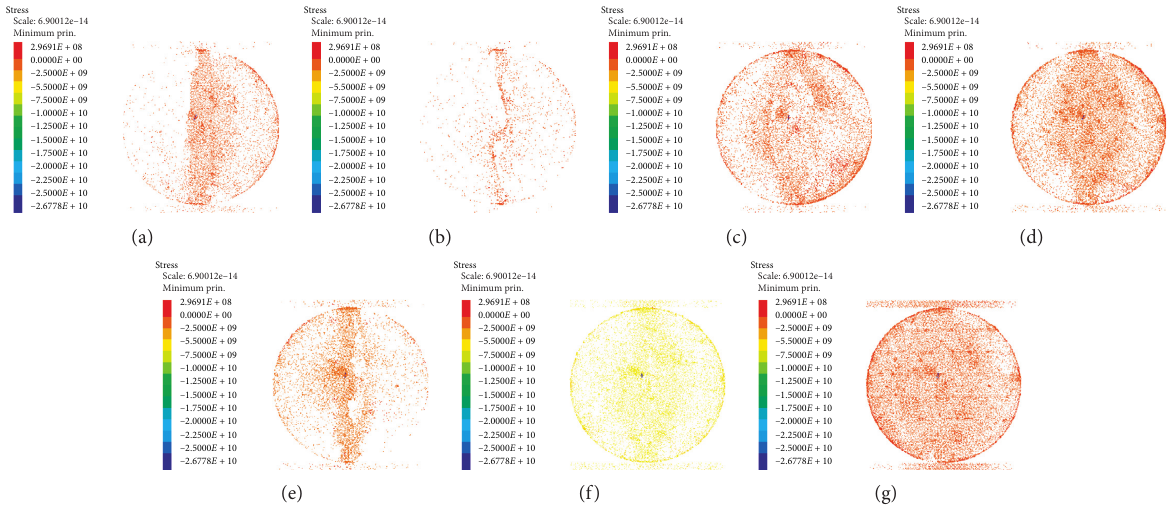
Figure 12: Loaded stress cloud with uniform parallel bedding model at different angles. (a) 0 ° . (b) 15 ° . (c) 30 ° . (d) 45 ° . (e) 60 ° . (f) 75 ° . (g) 90 °